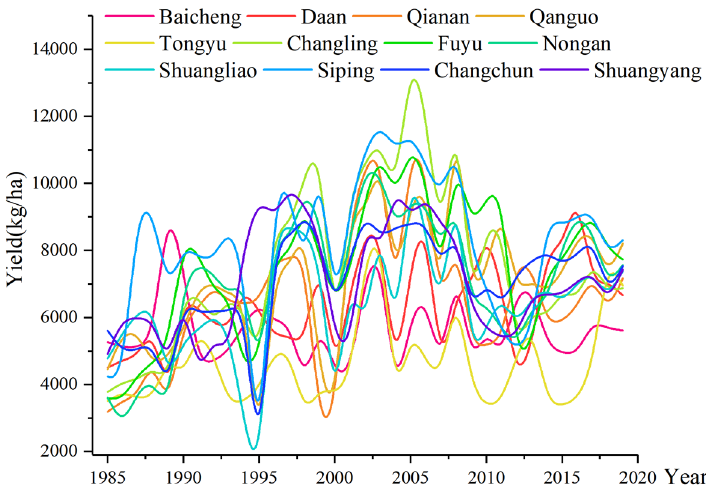
Figure 11. Fluctuation in the yield of maize in prefectural regions.